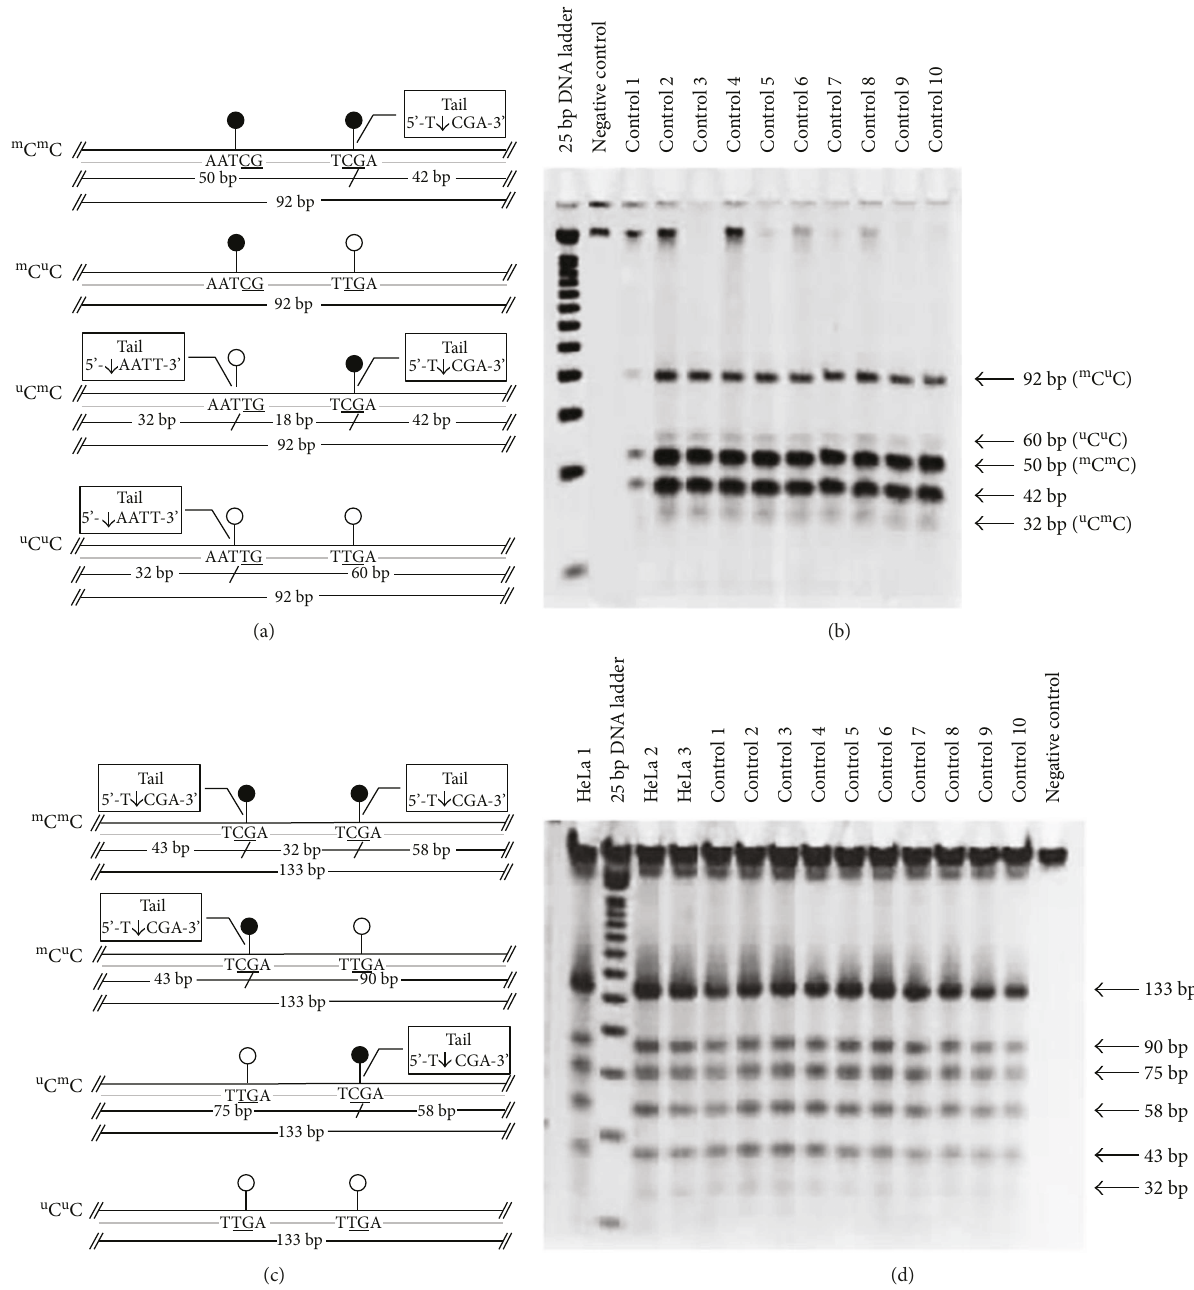
Figure 1: Combined-bisul fi te restriction analysis (COBRA) for LINE-1 (a, b) and Alu (c, d) methylation patterns. The diagrams (a, c) demonstrate the following four patterns of methylated CpGs (from top to bottom): hypermethylation ( m C m C), hypomethylation ( u C u C), and two forms of partial methylation ( m C u C and u C m C). Polyacrylamide gel electrophoresis (b, d) shows the locations for the bands for each pattern of methylated CpGs. Quantitative DNA ladder was used to assess the size of the bands. The representative gels of cell line and normal control samples are shown. Water is used as a negative